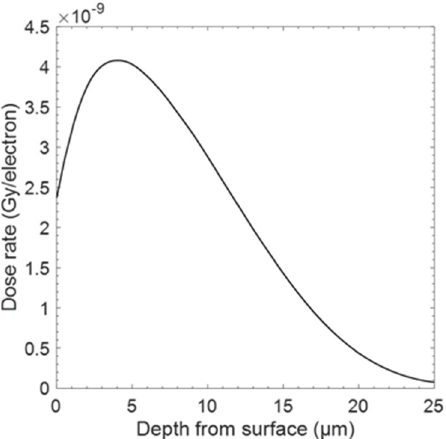
Figure 3. Calculation result of dose rate as a function of the depth from surface.